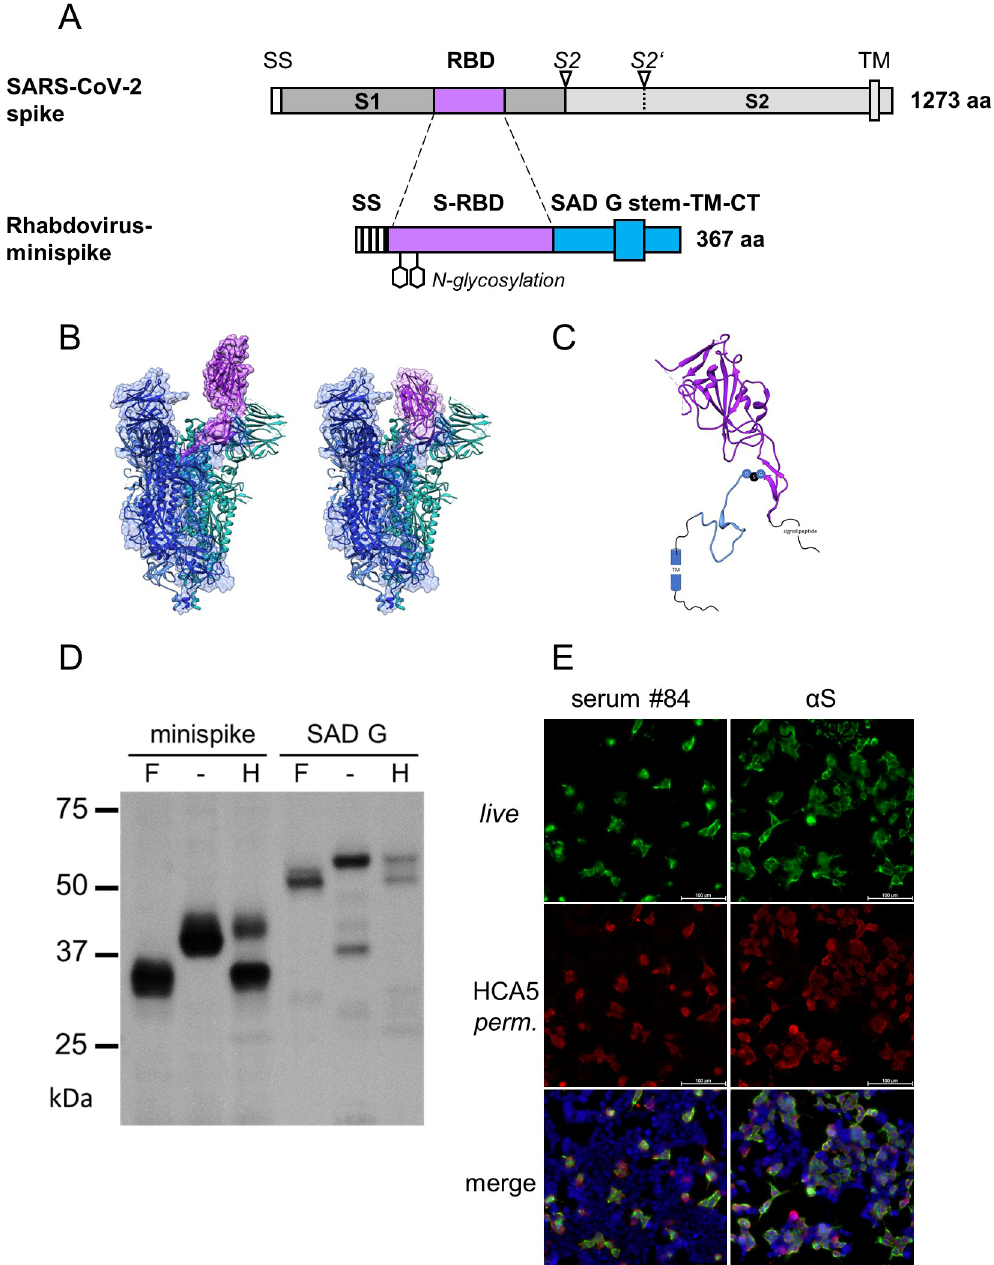
Fig 1. Design and expression of minispike. (A) Schematic representation of the SARS-CoV-2 spike protein and of the chimeric minispike protein containing a hIgG signal sequence (SS) the SARS-CoV-2 RBD (purple), and the RABV G stem/ anchor sequence (blue). Two consensus N-gylcosylation sites are indicated. S2 and S2 0 arrowheads indicate protease cleavage sites, TM transmembrane domain. (B) Ribbon model of the SARS-CoV-2 S protein in the RBD “up” (PDB 6VYB) and “down” (PDB 6VXX) conformation with RBD residues included in the minispike protein highlighted in purple. The EM density map is shown in grey. (C) Model of the chimeric minispike construct. Elements with available structural information are shown as ribbon diagrams and include the RBD of SARS-CoV-2 (purple, PDB 6VXX) and parts of the RABV G-protein (blue, PDB 6LGX). The GSG Linker connecting the two domains is depicted as blue (G) and black (S) circles. Elements of unknown structure including signal peptide and C-terminus of RABV G are shown as black lines. A blue cylinder (TM) indicates the transmembrane domain. (D) Complex N glycosylation of minispike protein. Extracts from HEK293T cells transfected with pCR3-minispike and RABV G as a control were treated with PNGase F (+F), which cleaves off all N-linked oligosaccharides, left untreated (-) or treated with Endoglycosidase H (+H), unable to cleave complex